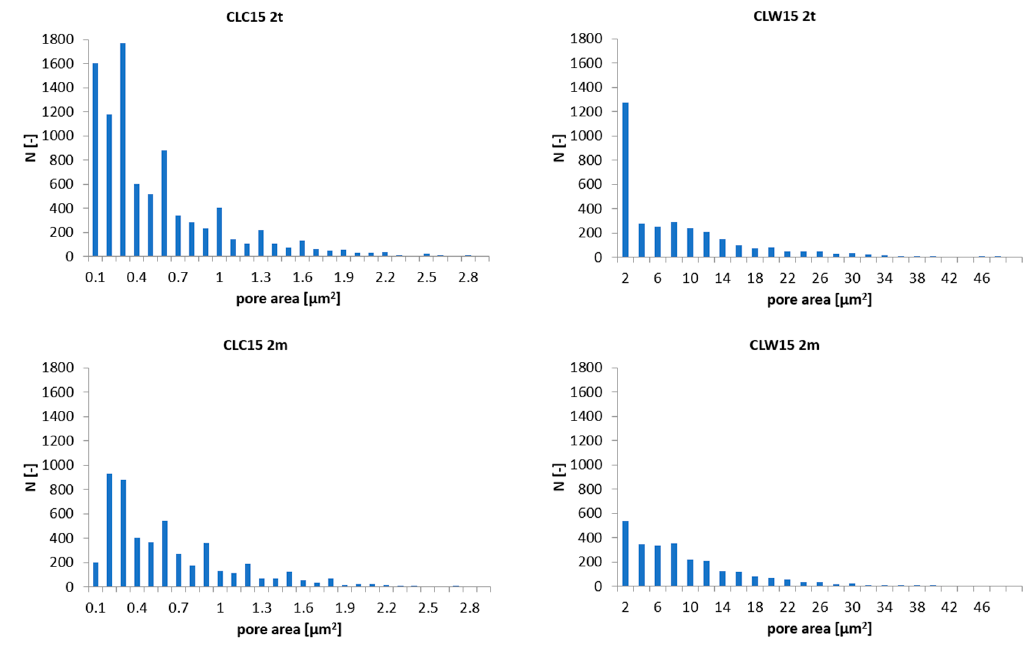
Figure 7. Pore size distributions in the near-surface (2t) and central (2m) regions of the CLC15 and CLW15 samples.